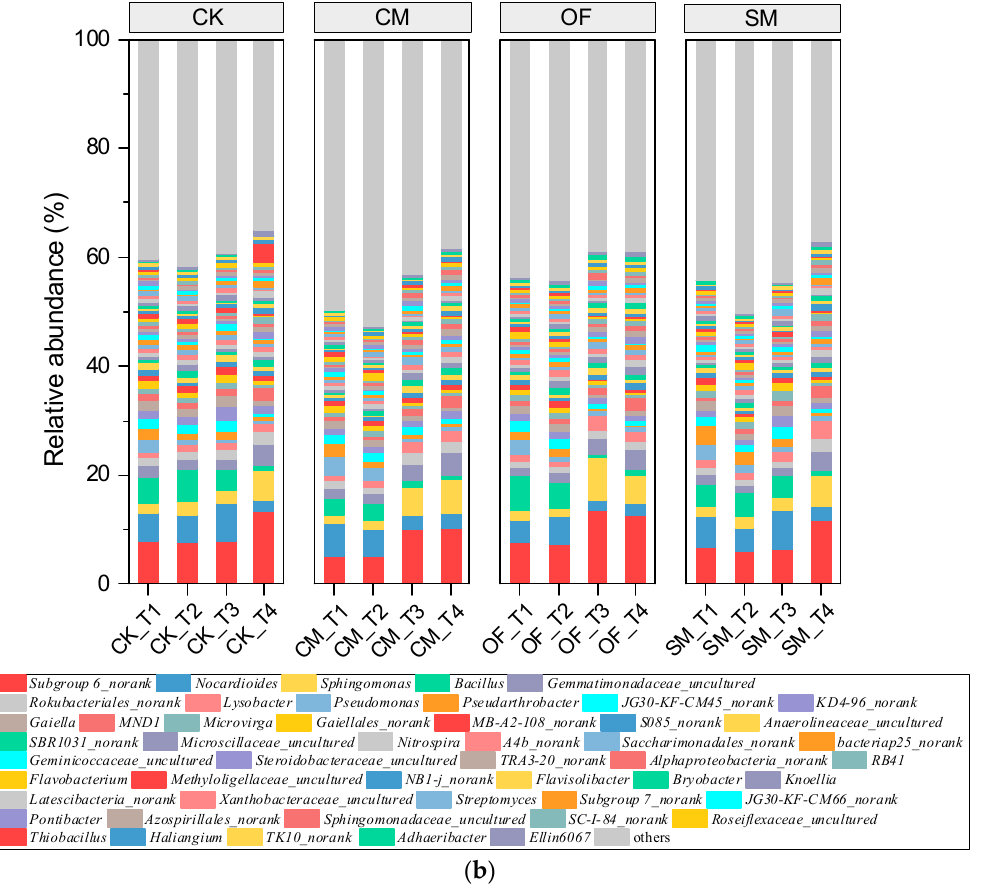
Figure 3. The relative abundances of microorganisms on phylum ( a ) and genus ( b ) levels with different fertilizers (CK: control; CM: chicken manure; OF: organic fertilizer; SM: swine manure; T1: seedling period; T2: three-leaf period; T3: filling period; T4: mature period).